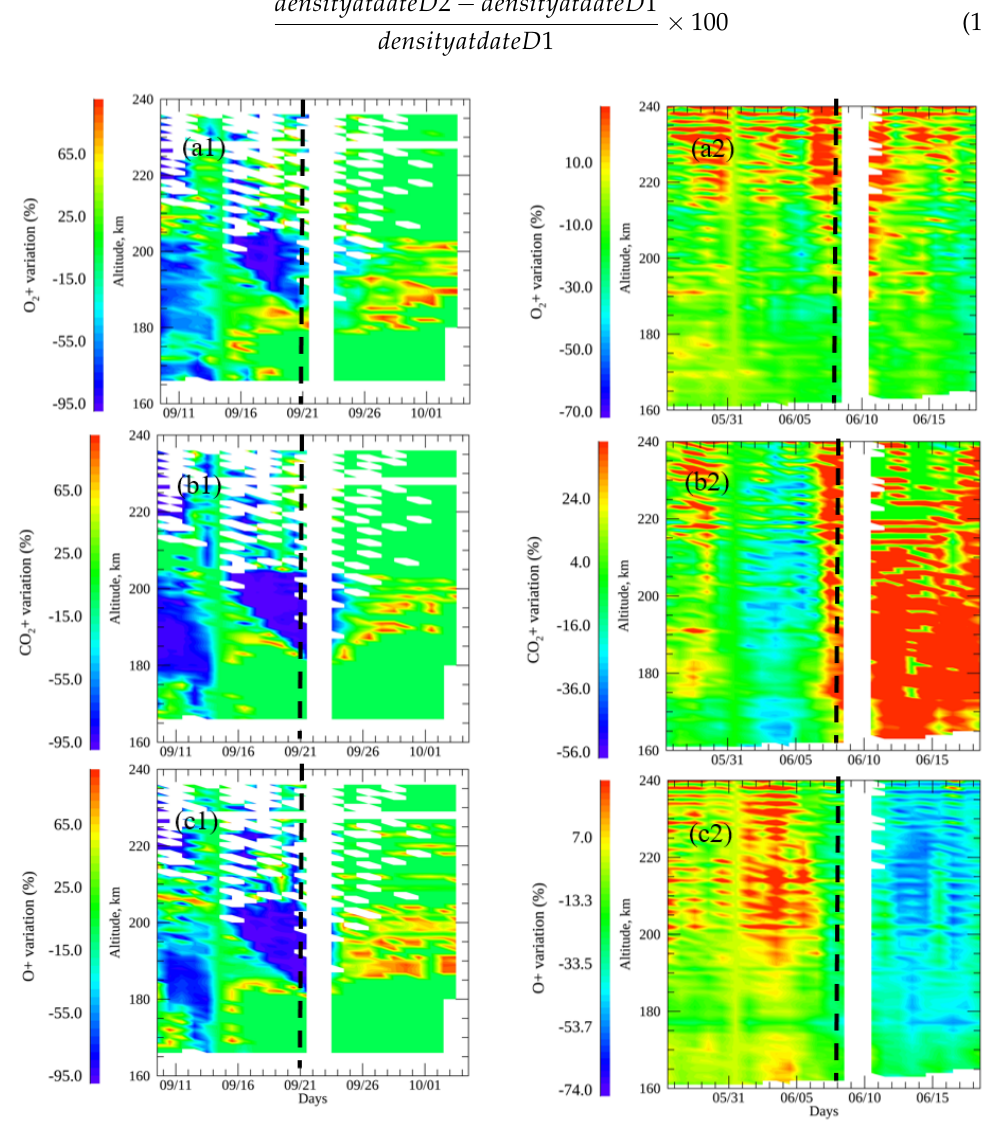
Figure 5. Distribution of (O 2+ , CO 2+ , and O + ) ion species density normalized to their own pre-storm densities as a function of altitude ( a1 – c1 ) 9 September–2 October 2016 (RDS 2016); ( a2 – c2 ) 27 May to 17 June 2018 (GDS 2018). The vertical black line indicates the storm onset. The blank regions represent missing data.